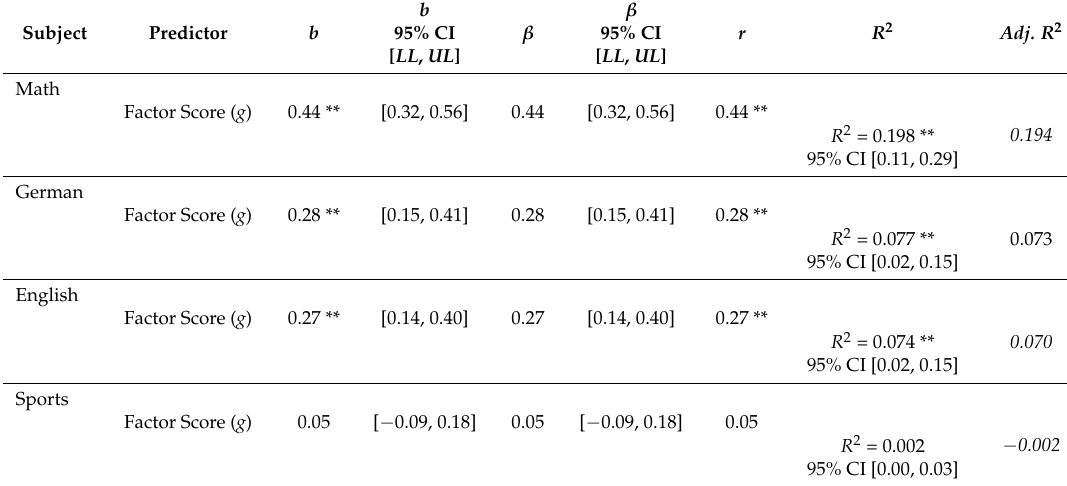
Table 2. Regression results using the different grades as criteria and the factor score ( g ) as